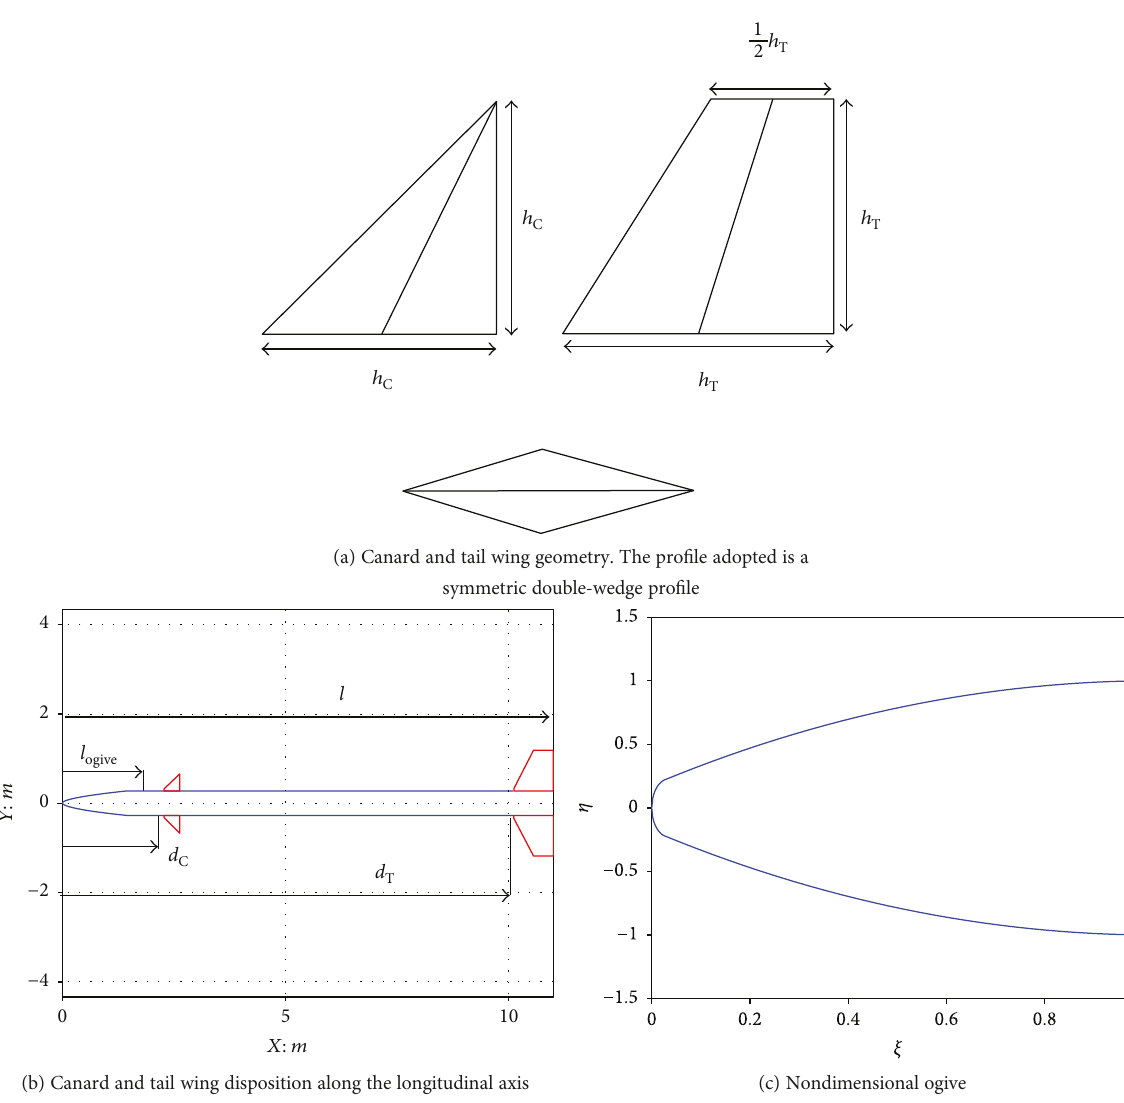
Figure 2: Main surfaces and reference quantities.